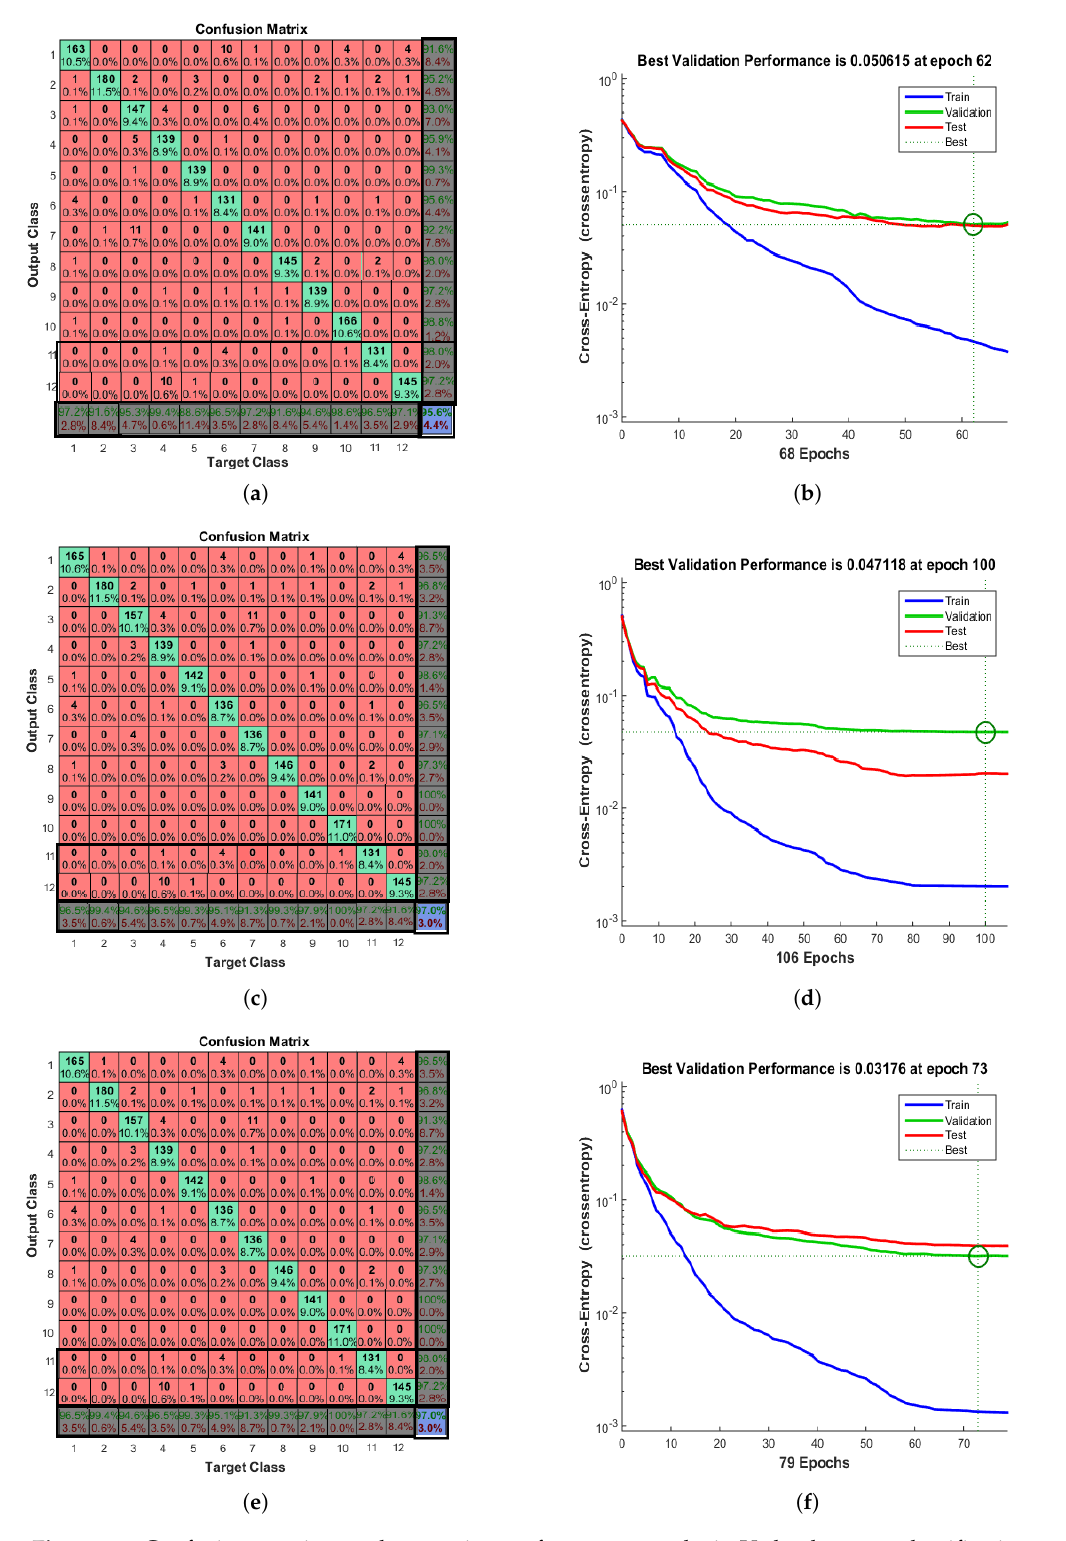
Figure 16. Confusion matrices and respective performance graphs in Urdu character classification. ( a ) Accuracy result with 10 hidden neurons; ( b ) best validation performance with 10 hidden neurons; ( c ) accuracy result with 30 hidden neurons; ( d ) best validation performance with 30 hidden neurons; ( e ) accuracy result with 50 hidden neurons; ( f ) best validation performance with 50 hidden